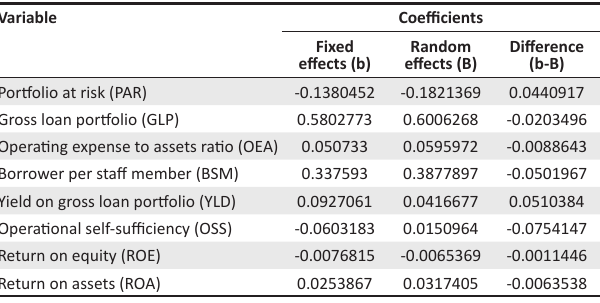
TABLE 2: Hausman specification test: fixed effects vs. random effects for microfinance institutions